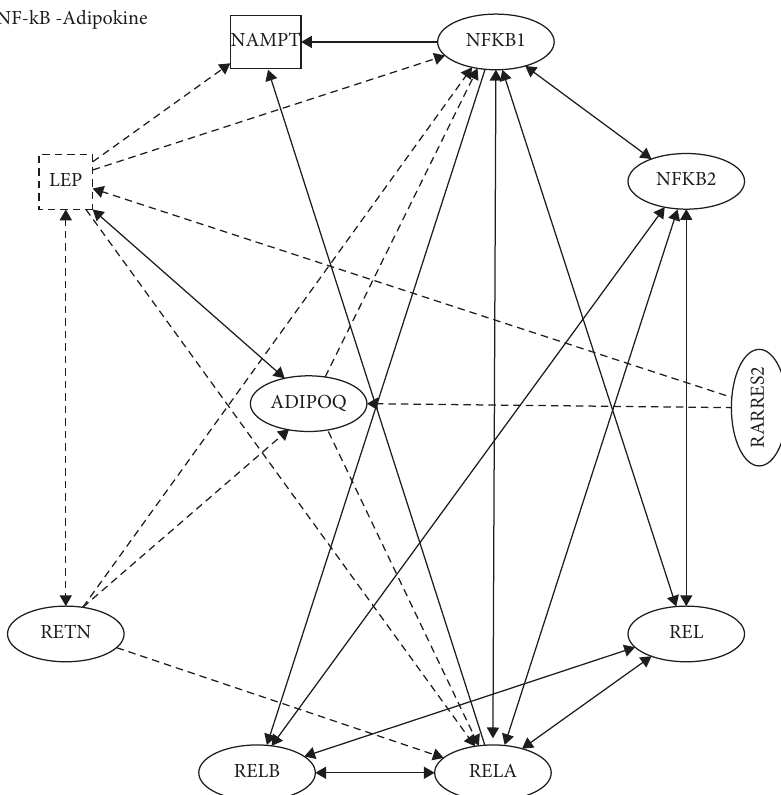
Figure 3: NF- κ B and adipokines. IPA showed the molecular pathways of stellakines and NF- κ B networks. LEP: leptin, ADIPOQ: adi- ponectin, RETN: resistin, NAMPT: nicotinamide phosphoribosyl transferase. Solid lines indicate direct regulation; dashed lines indicate indirect